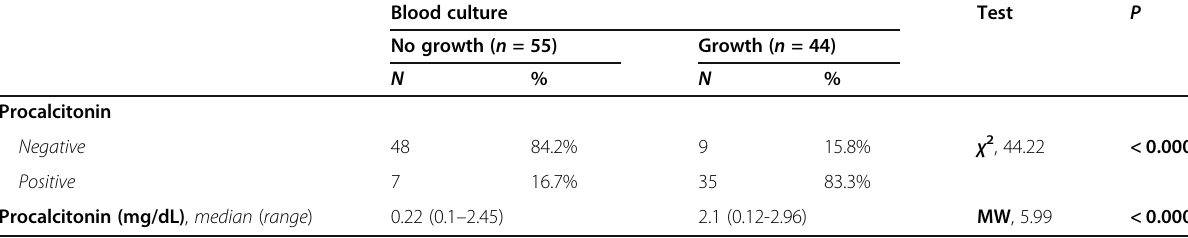
Table 3 Procalcitonin in different blood culture results in the studied groups ( n = 99)